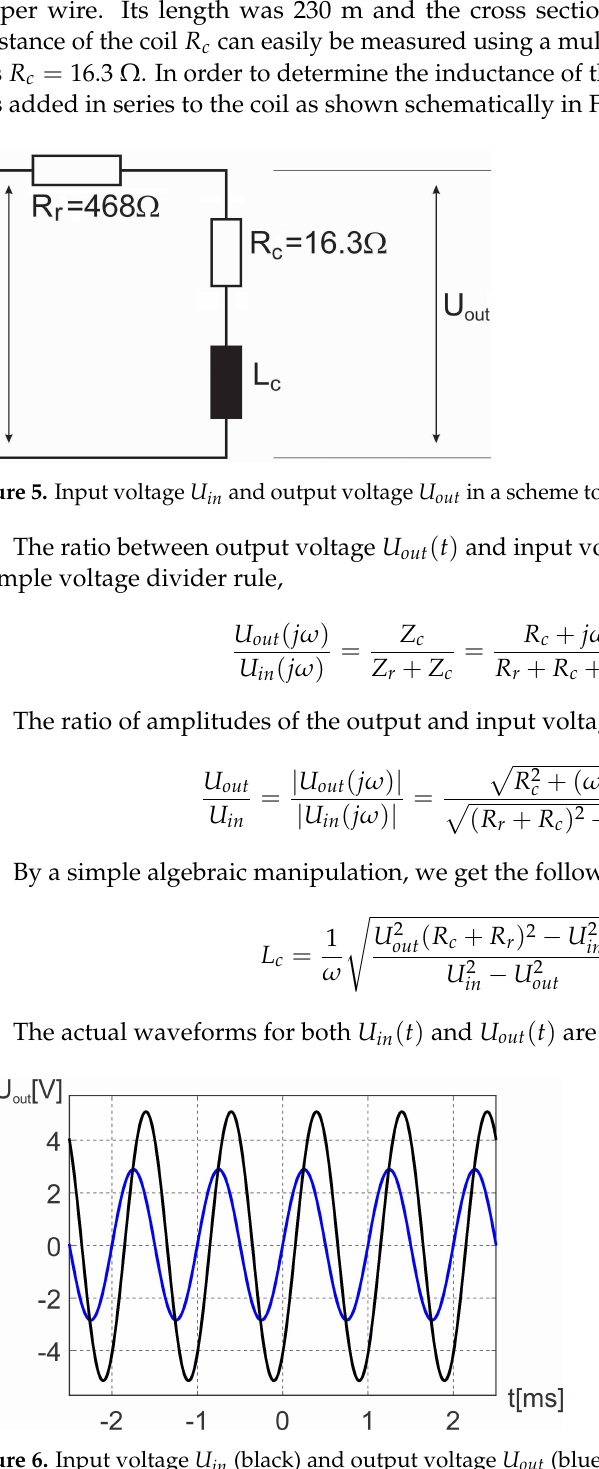
Figure 6. Input voltage U in (black) and output voltage U out (blue) for the circuit shown in Figure 5. For the signal U in = 5.12 V and ω = 6280 rad/s we get the U out = 2.87 V. Finally, using Equation (9) we get L c = 52.1